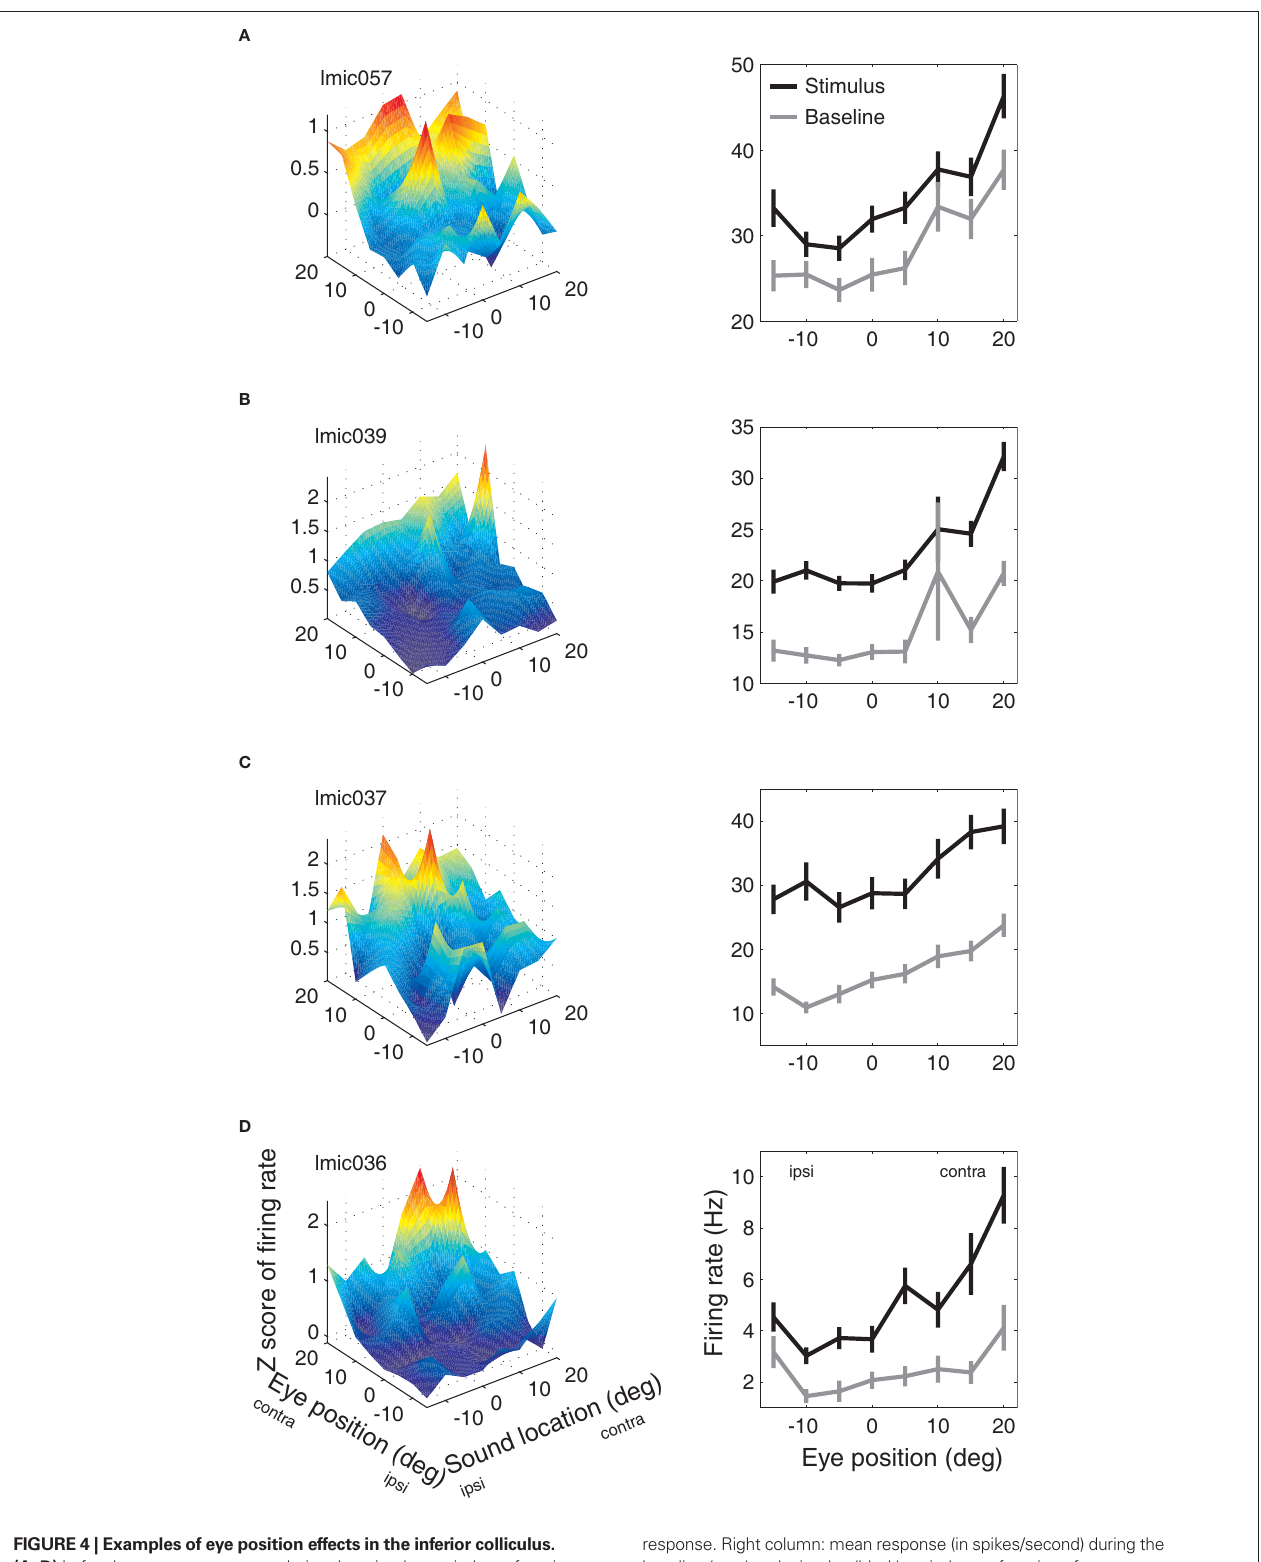
FIgure 4 | examples of eye position effects in the inferior colliculus. (A–d) Left column: mean response during the stimulus period as a function of eye position and sound source location. Mean response is expressed as the Z -score of the response compared to the average baseline